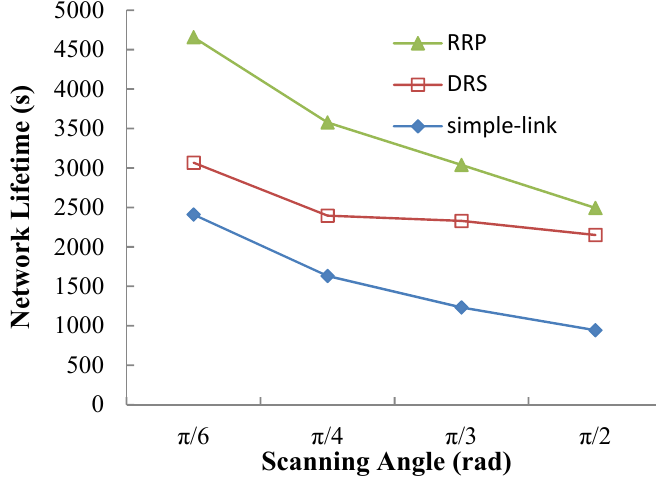
Figure 11. Network lifetime vs. scanning